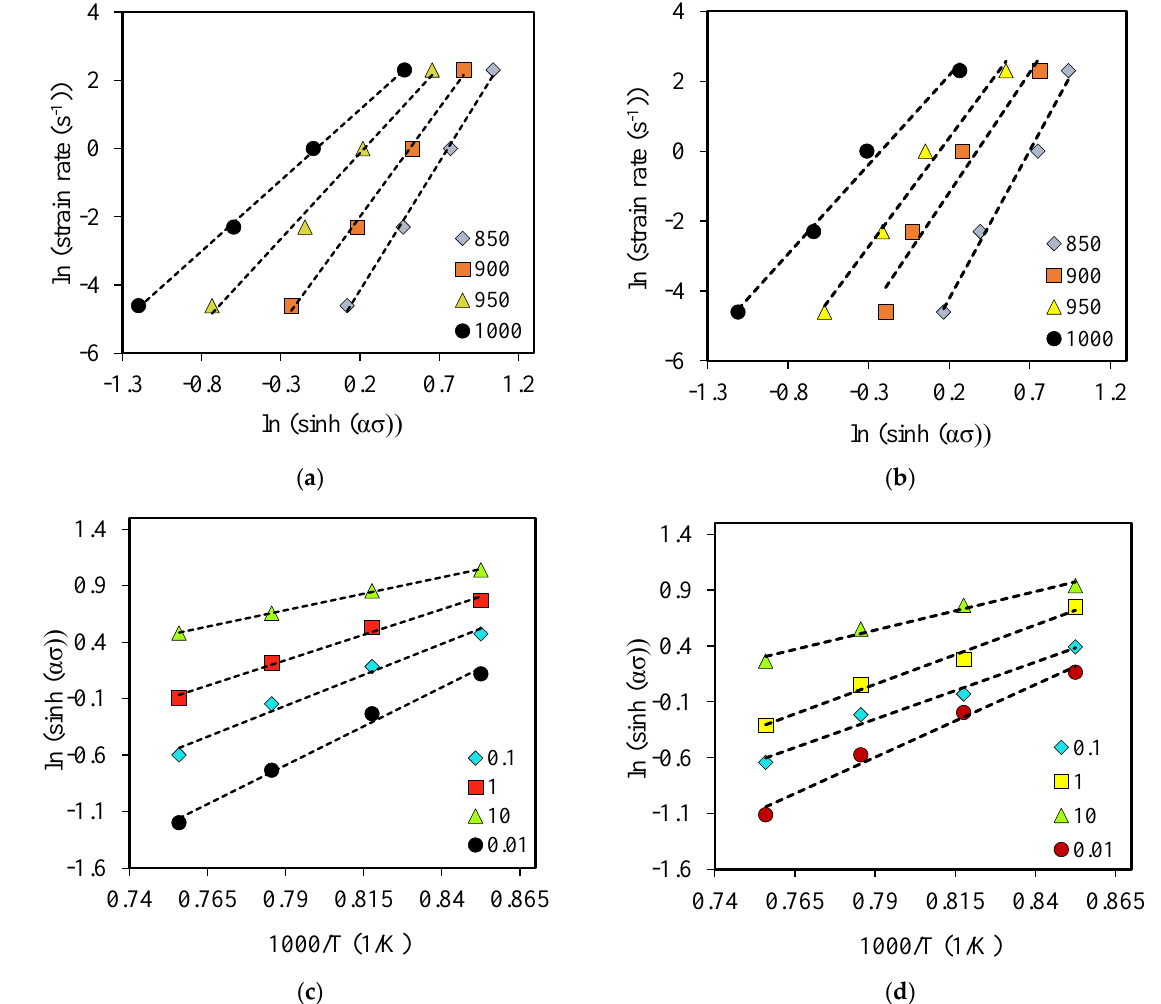
Figure 8. ( a , b ) Plots of ln έ versus σ and ln (sinh (σα)) for determination of n and ( c , d ) are plots of ln (sinh (σα)) versus (1000)/T to determine S value for steel A and steel B, respectively. The relationship between the flow stress and the Zener–Holloman parameter is given in Equation (6). The structure factor (A) is determined by taking logarithms on both sides of Equation (6), as in Equation (14) [21]. The A value is the intercept of the best fit line obtained by plotting ln (Z) versus ln (sinh(ασ)), as shown in Figure 9 [52].